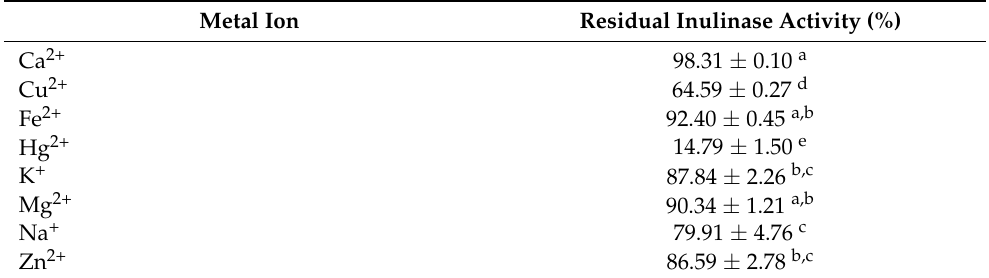
Table 6. Effect of metal ions at 10 mM concentration on the hydrolytic activity of inulinase from Aspergillus terreus URM4658.